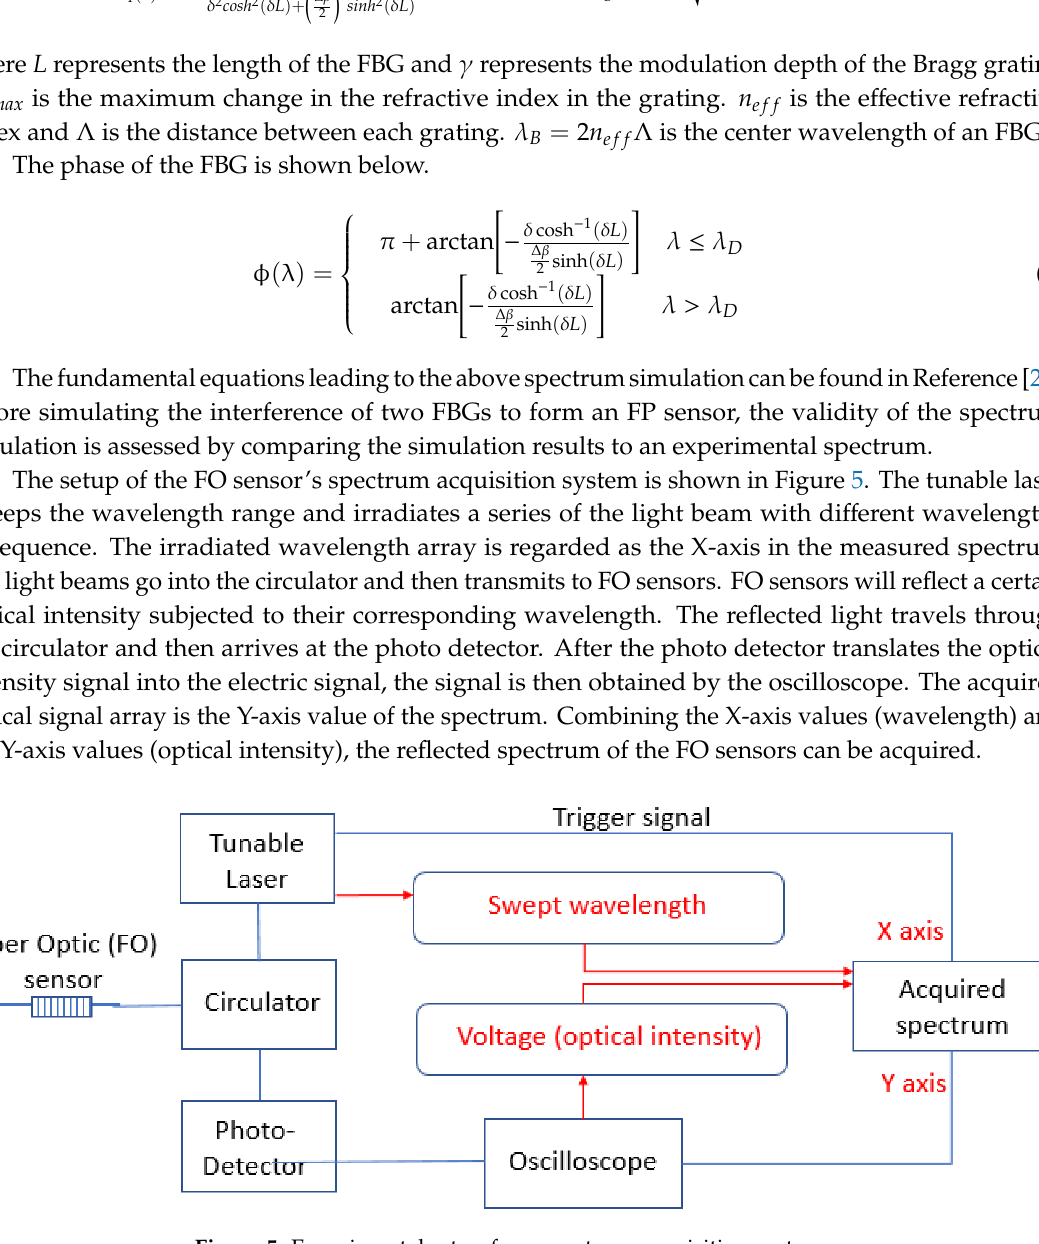
Figure 5. Experimental setup for a spectrum acquisition system.